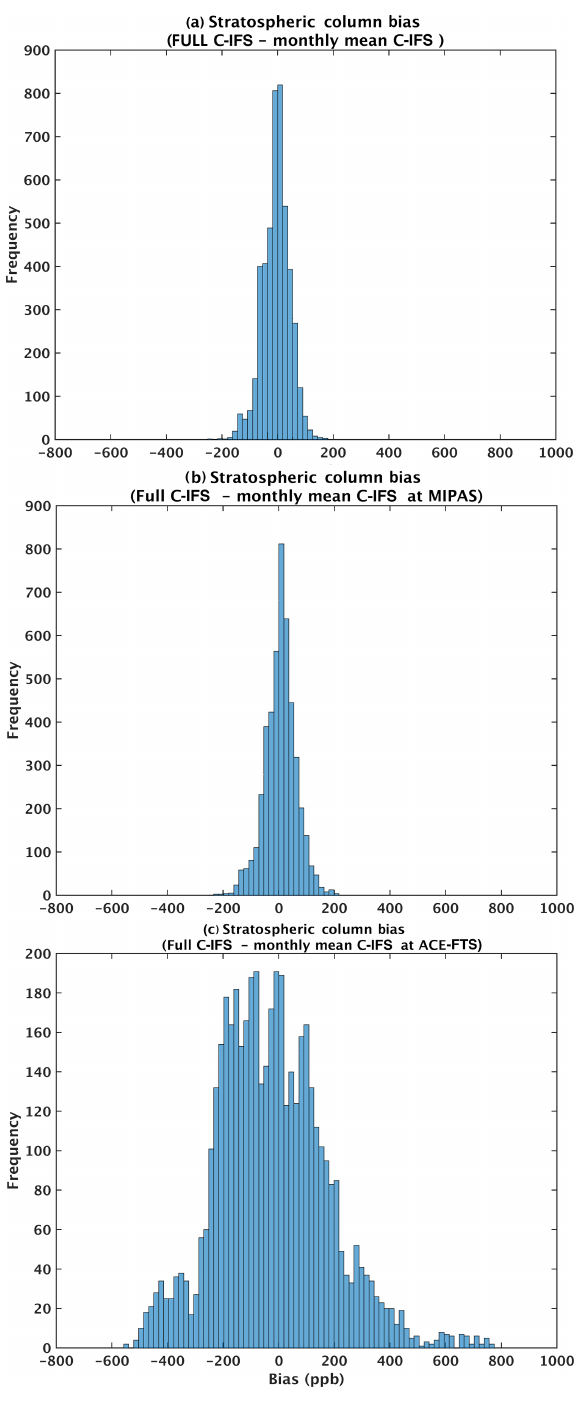
Figure 11. Distribution of the stratospheric column bias estimated at the location of the MOZAIC airports and using FULL C-IFS as the reference truth. Panel (a) shows the bias when monthly mean fields from the C-IFS model are used for profile extension. Panels (b) and (c) depict the bias when monthly mean fields from the C- IFS model obtained using the sampling from the MIPAS and ACE instruments are used for profile extension, respectively.